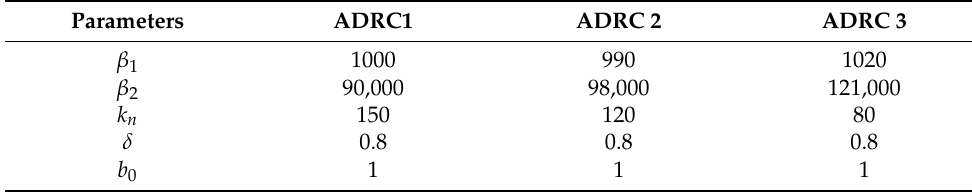
Table 4. Parameters of each ADRC controller.